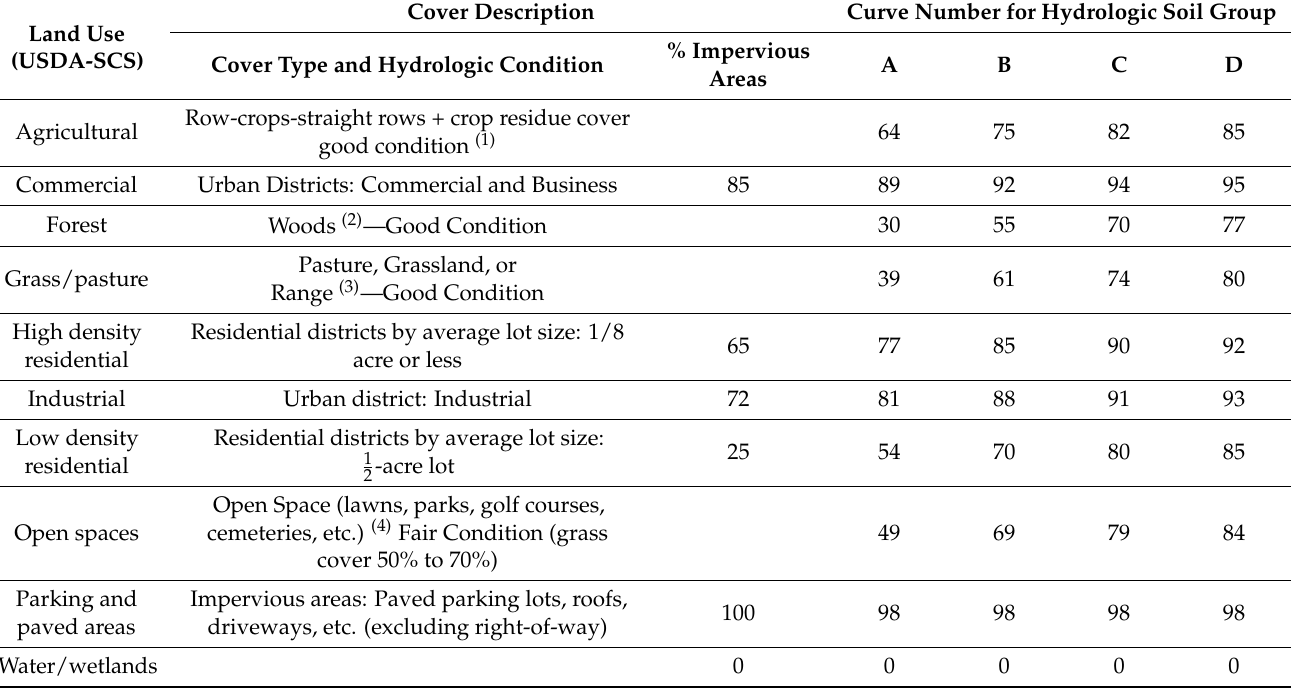
Table 2. Description and Curve Numbers of different land uses and hydrologic conditions under different hydrologic soil groups